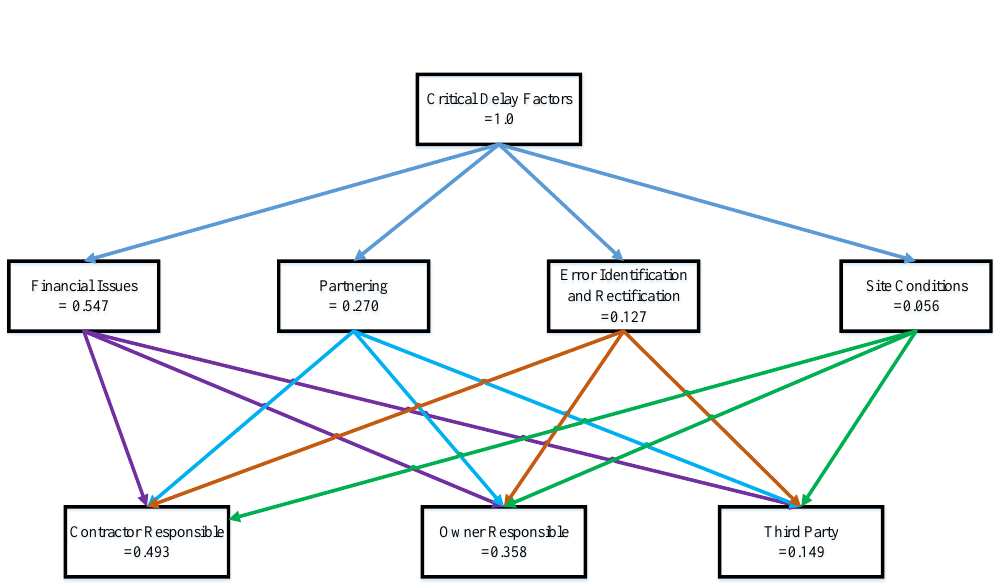
Fig. 2. Relative weights for a different criterion (developed by the